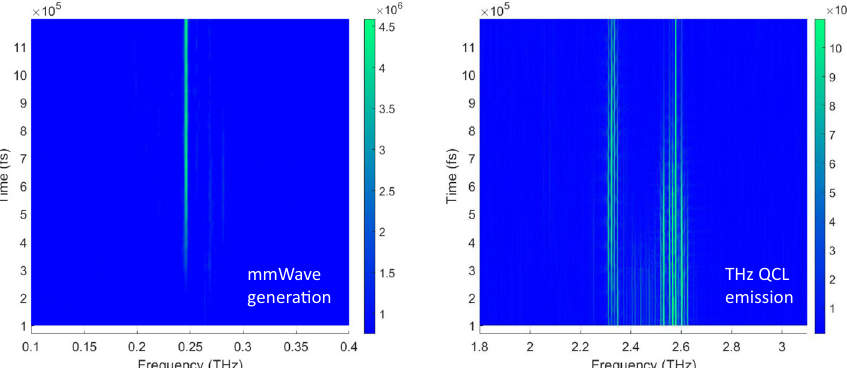
Fig. 6 Time resolved spectral emission from QCL 3 . The intensities of the spectral modes plotted as a function of frequency ( x ) and time in femtoseconds ( y -axis), showing the build-up and seeding of the THz QCL emission at ~400 ps centred ~2.45 THz (right) followed by the generation of stable mmWave emission at 244 GHz (left). The intensity of the emission (arb. units) is shown by the colour bar on the right of each fi gure.